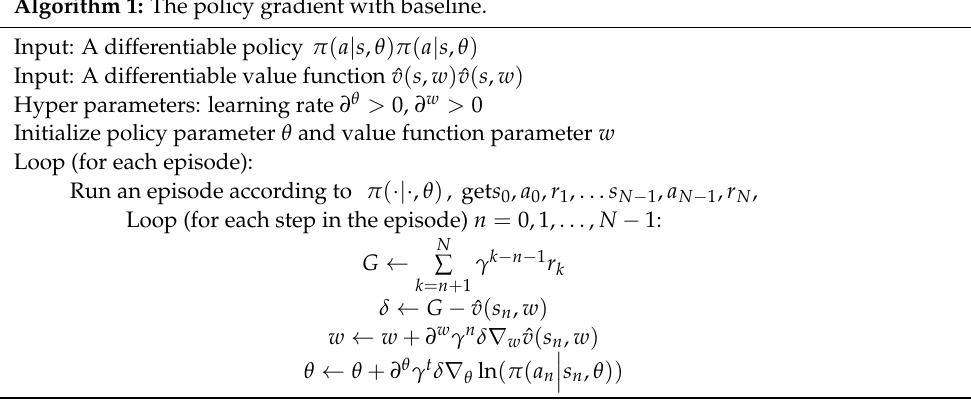
Algorithm 1: The policy gradient with baseline.